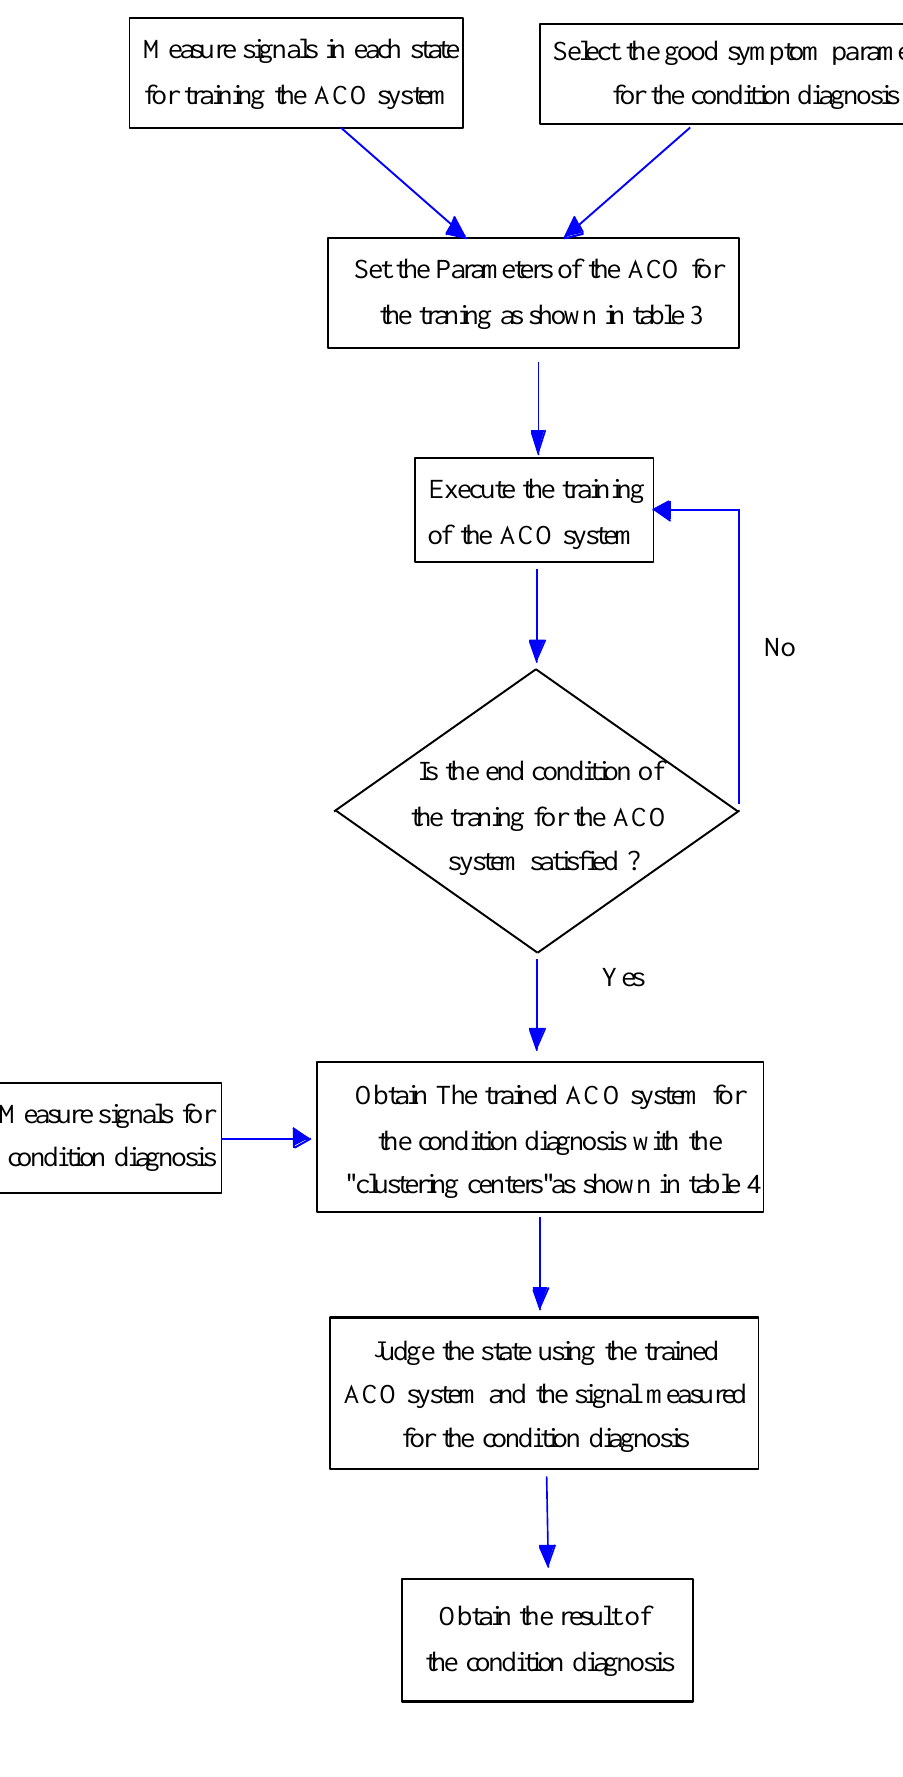
Figure 10. The flowchart of the condition diagnosis using the ACO